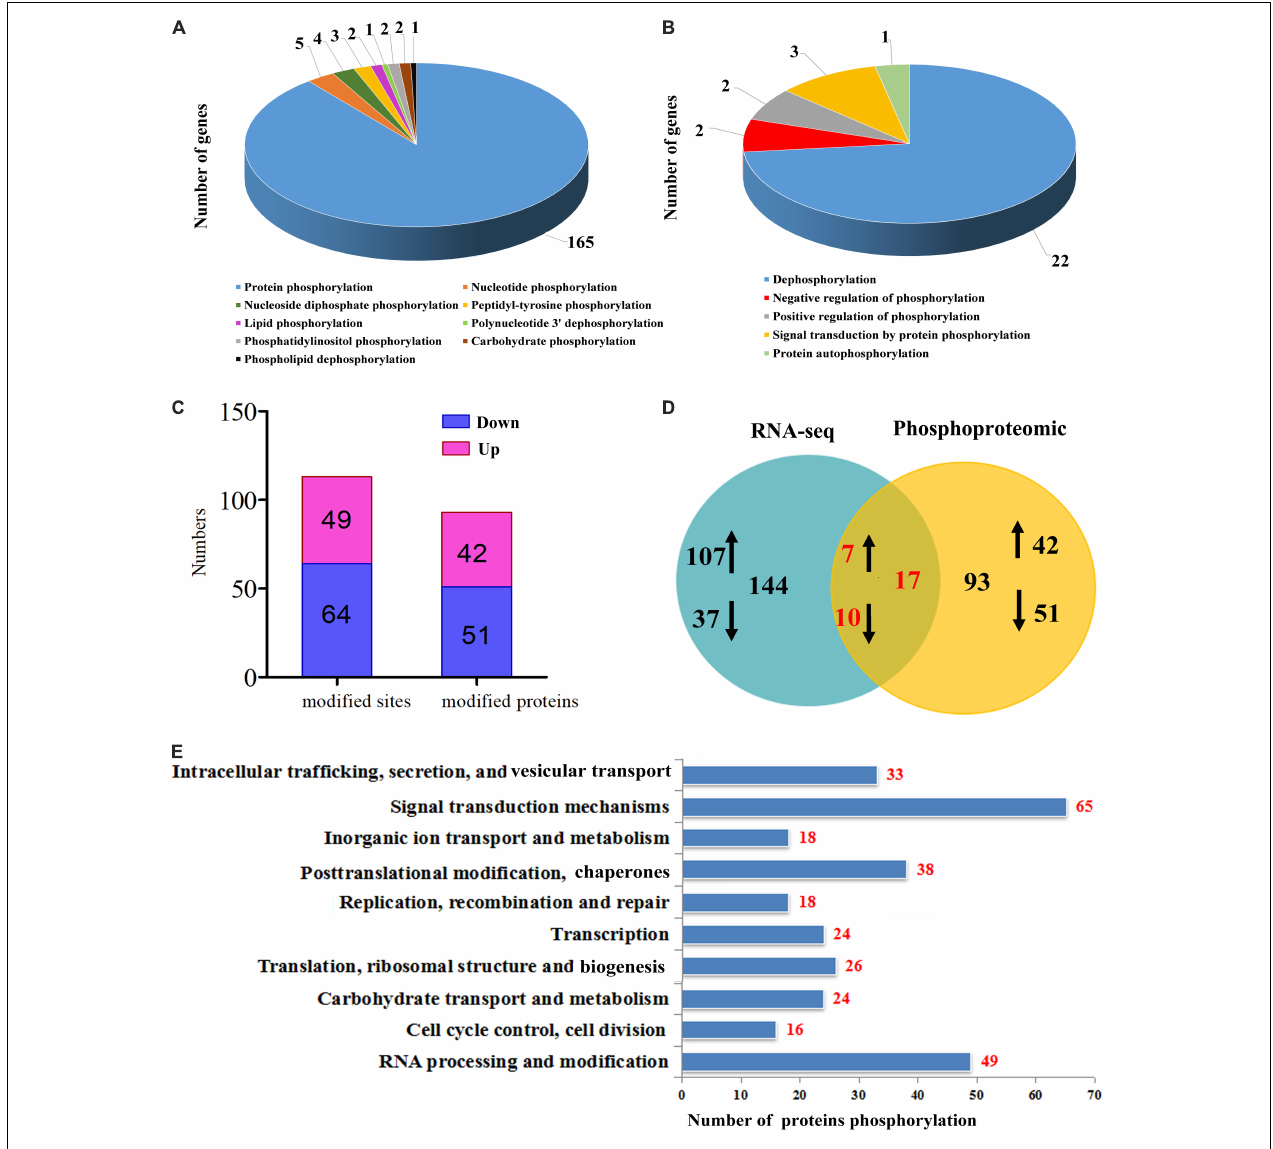
FIGURE 6 | Phosphorylation analysis in tetraploids Citrus wilsonii under drought stress. Type of phosphorylation modification (A) and modify the model of phosphorylation (B) from the RNA-seq data; differentially modified sites (modified proteins) at 2.0 ≤ fold changes or ≤ 0.5 (C) ; common and specific differentially phosphorylation modified proteins were compared between RNA-seq data and phosphoproteomic data (D) , and the up-regulated gene or protein marked by ↑ , down-regulated gene or protein marked by ↓ ; function classification of phosphorylation modified proteins (E)